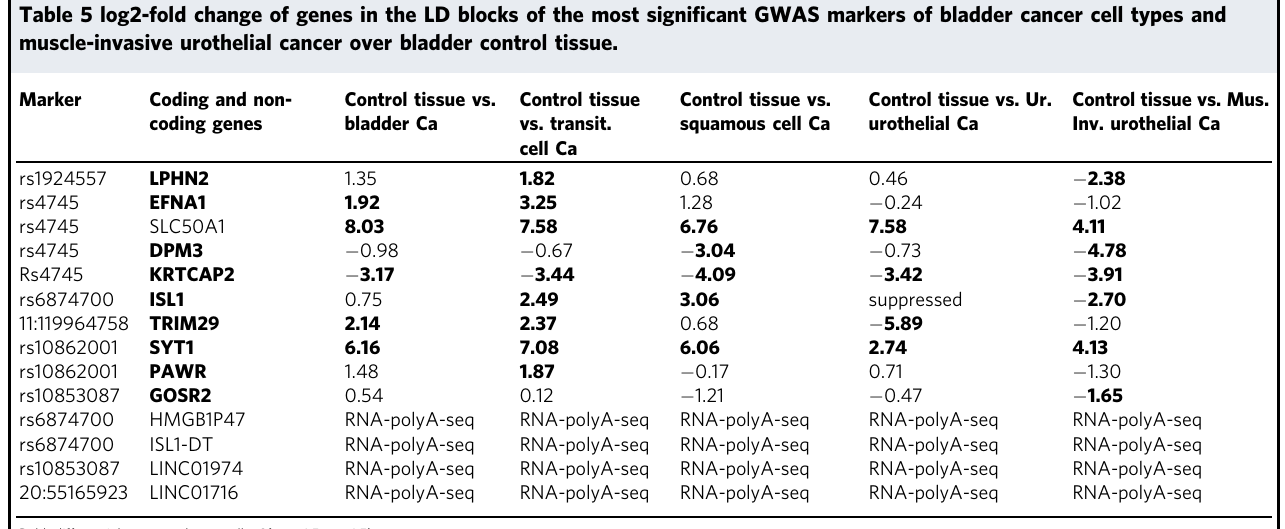
Table 2). Sequencing fi les for patient, parent, and control DNA were added to databases created using PreGap4 software, with control DNA processed as the reference sequence.